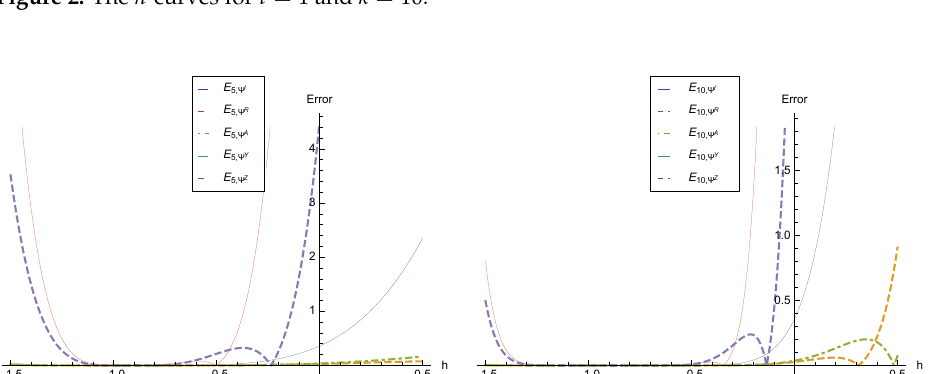
Figure 2. The ¯ h -curves for t = 1 and k = 10.